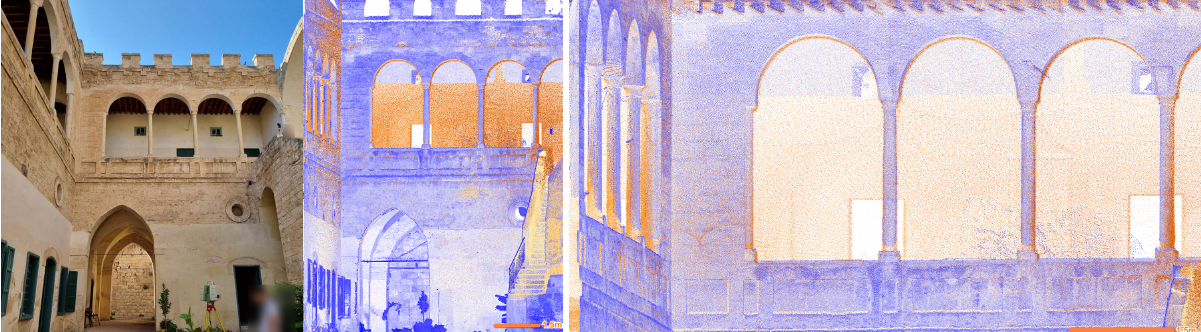
Figure 3. The Seraya site, data collected by an Leica C10 scanner and GeoSLAM Zeb Revo following registration. TLS points are colored in blue, PLS point in orange. For denoising evaluation, we use the TLS data at overlapping area as ground truth.